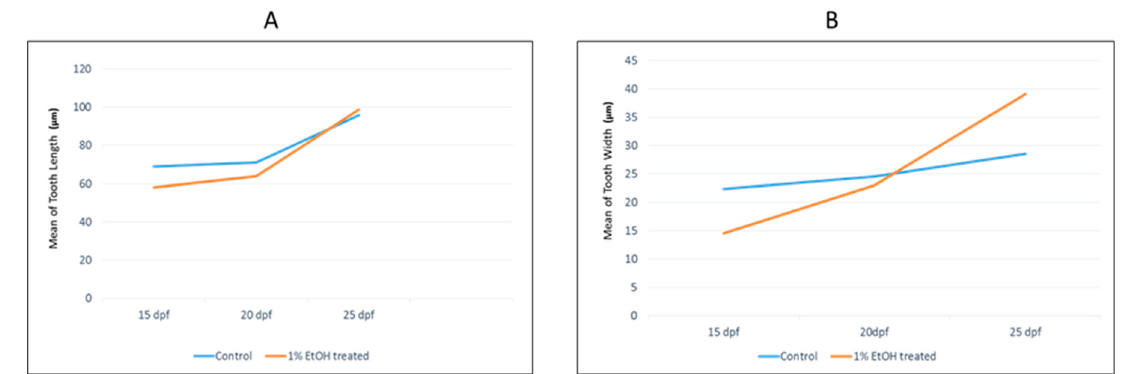
Figure 2. Comparing the tooth ( A ) length and ( B ) width in control and 1% alcohol-treated samples at 15 days post-fertilisation. In ( A ), the mean length is 69.71 µm for the control group and 58.23 µm for 1% alcohol-treated group. There was a significant difference ( p < 0.05) between the groups. In ( B ), the mean width was 22.73 µm for control group and 14.22 µm for the 1% alcohol-treated group. There was a significant difference between the groups. Figure 3. Comparing the mean tooth length in the control and 1% alcohol-treated samples at 15, 20 and 25 days post-fertilisation (dpf) ( A ). Comparing the mean tooth width in control and 1% alcohol- treated samples at 15, 20 and 25 dpf ( B ).